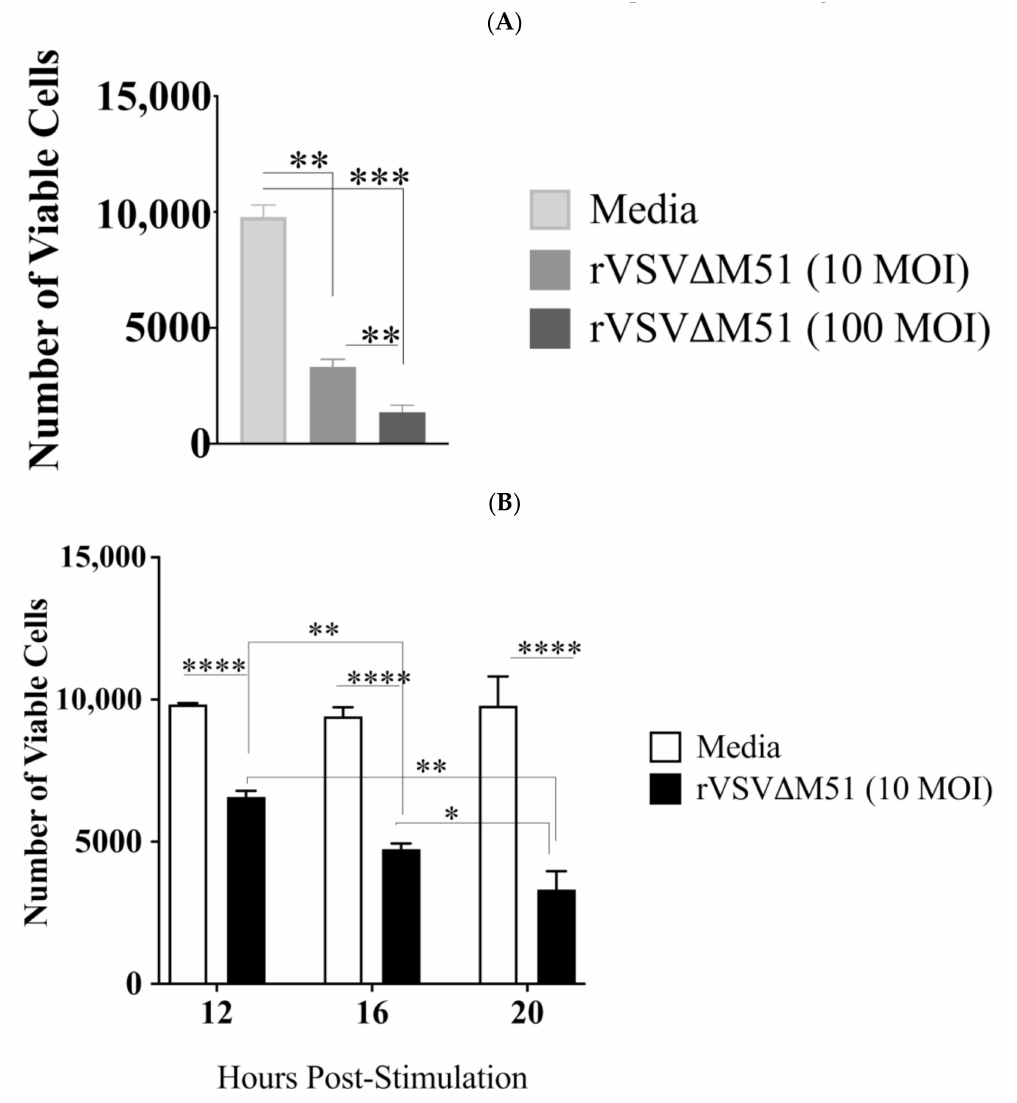
Figure 4. Infection of murine bone-marrow-derived mast cells (BMMCs) with recombinant vesicular stomatitis virus (rVSV ∆ m51) resulted in cell death. BMMCs were infected with rVSV ∆ m51 at a multiplicity of infection (MOI) of 10, and at various time points the cells were stained for the surface markers Fc ε RI α and c-kit. A cell viability dye to discriminate live and dead BMMCs was applied to the cells before flow cytometry analysis. Graphs show means and standard deviations pooled from four experimental replicates of the number of viable cells among total Fc ε RI α + c-Kit + BMMCs at ( A ) 20 h post-infection with 10 or 100 MOI of the virus and ( B ) at 12, 16, and 20 h post-infection with 10 MOI of the virus. Two-way analysis of variance with Tukey’s multiple comparison test was used to define statistical significance as * p < 0.05; ** p < 0.001; *** p < 0.0005; **** p <